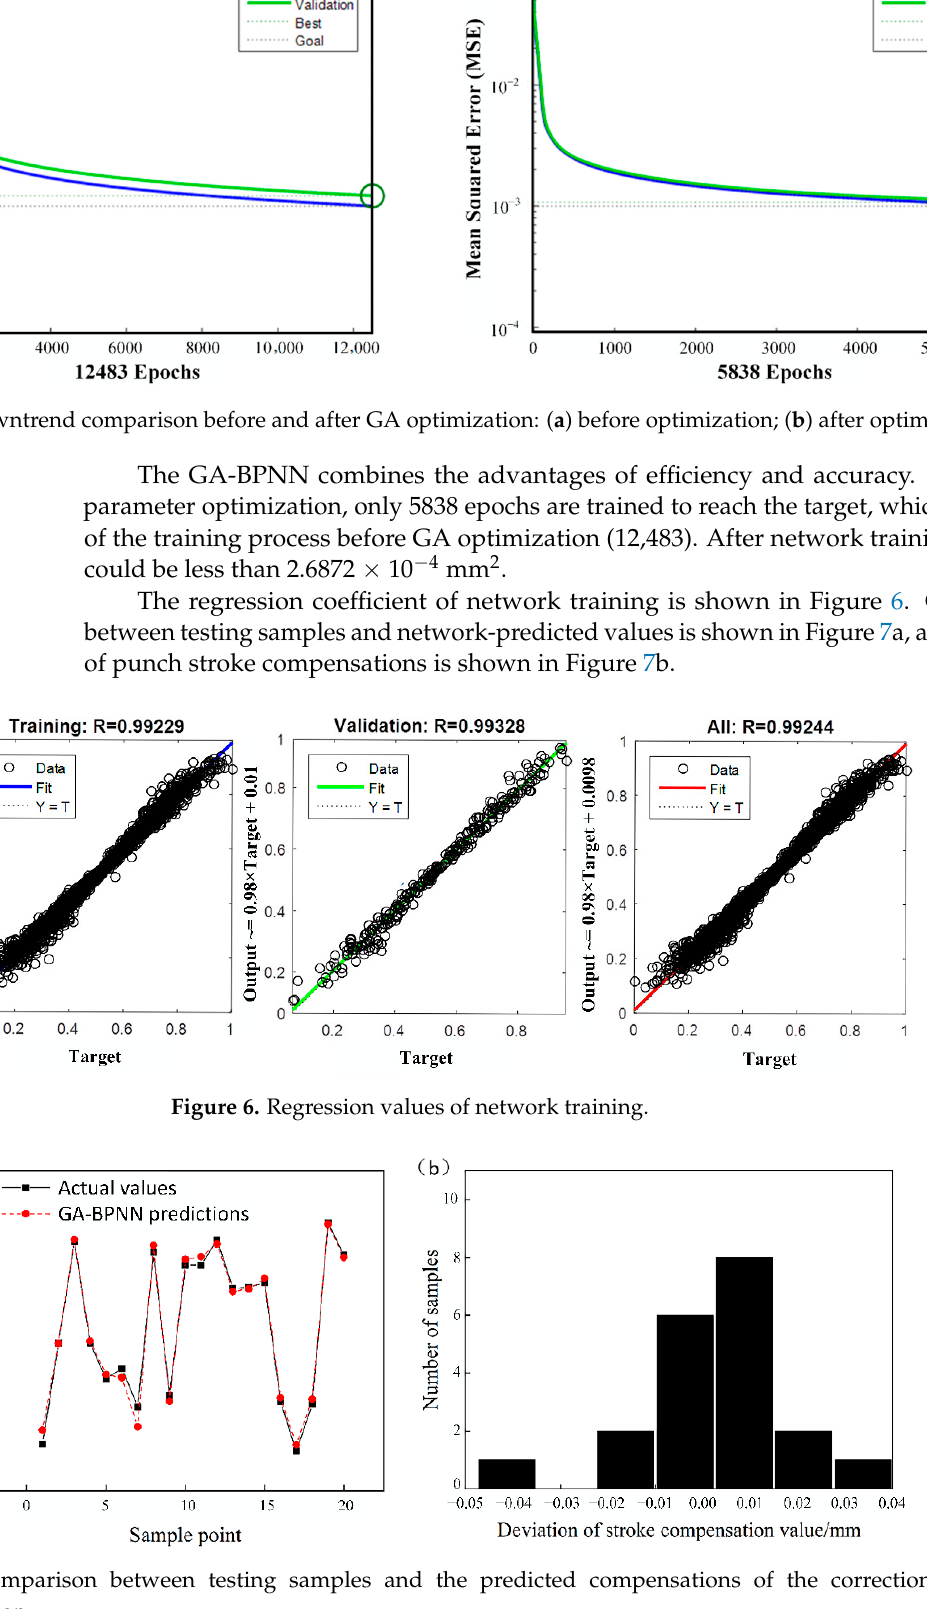
Figure 7. ( a ) Comparison between testing samples and the predicted compensations of the correction model. ( b ) Stroking